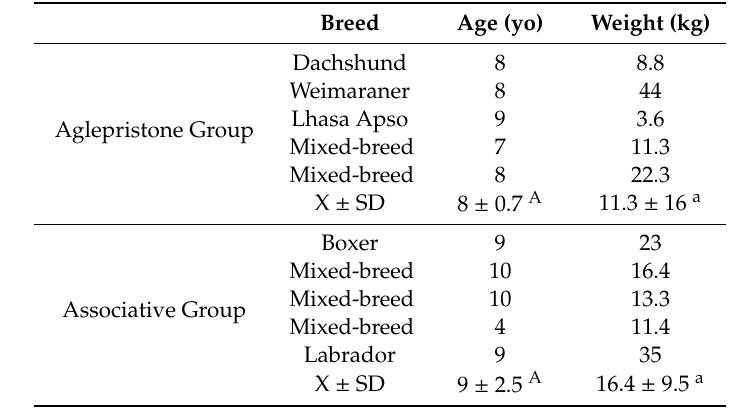
Table 1. Females features (breed, age and weight) in the Aglepristone (n = 5) and Associative (n = 5)